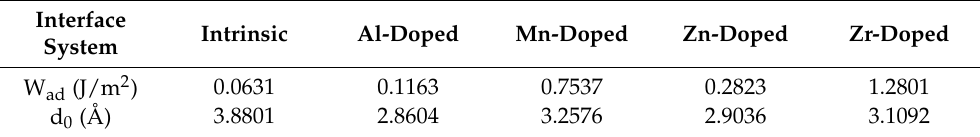
Table 6. Interface adhesion works (W ad ) and interface spacings (d 0 ) of five interface models.